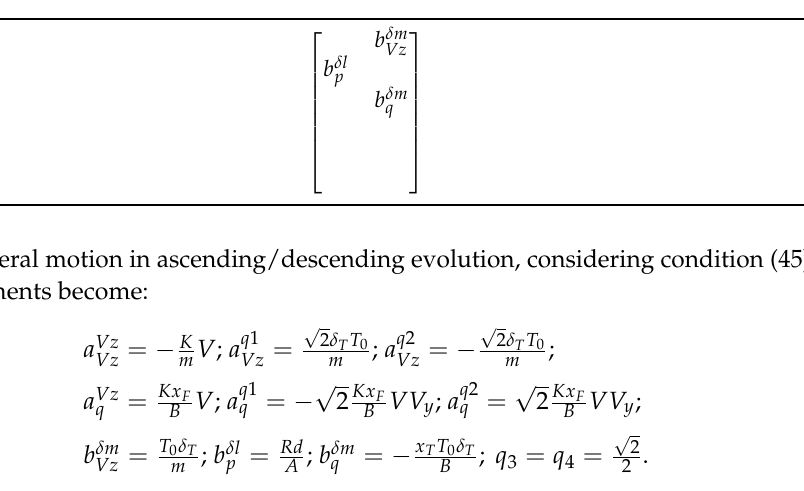
Table 8. Command matrix for lateral motion B